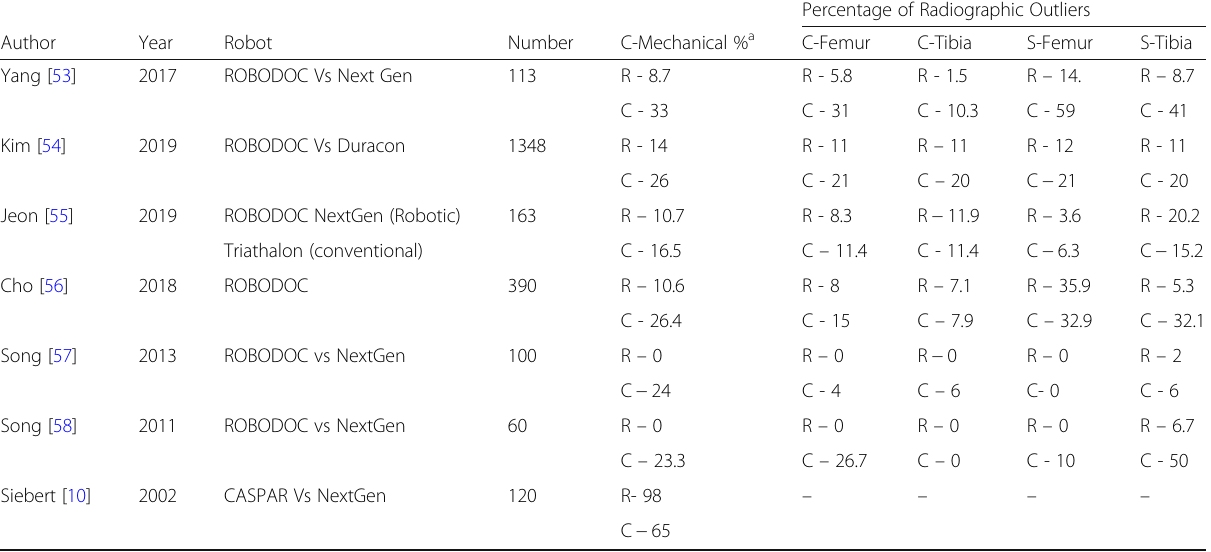
Table 3 Studies Comparing Radiographic Outliers in RATKA Versus Conventional TKA